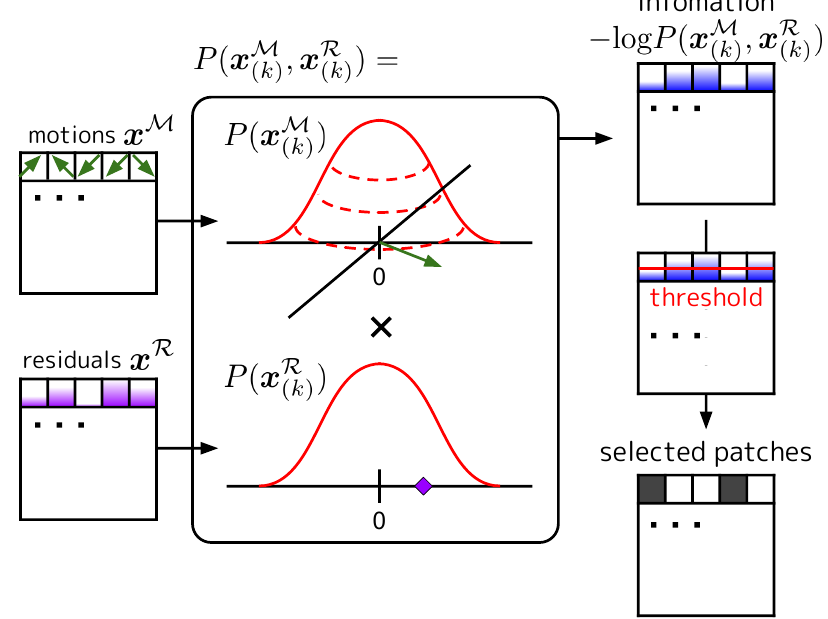
Figure 3. Diagram of IPS. We model the distributions of the motions and residuals in a patch of P-frames and calculate the amount of information content in each patch. Patches with information content above the threshold are selected as input into the video